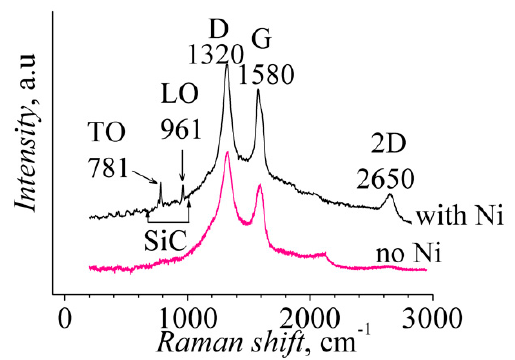
Figure 7. Raman spectra of Ni-containing and control samples annealed at 800 °C.